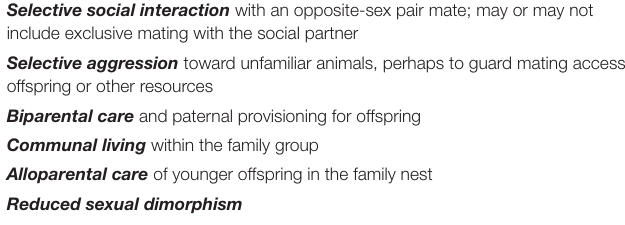
TABLE 2 | Features of social